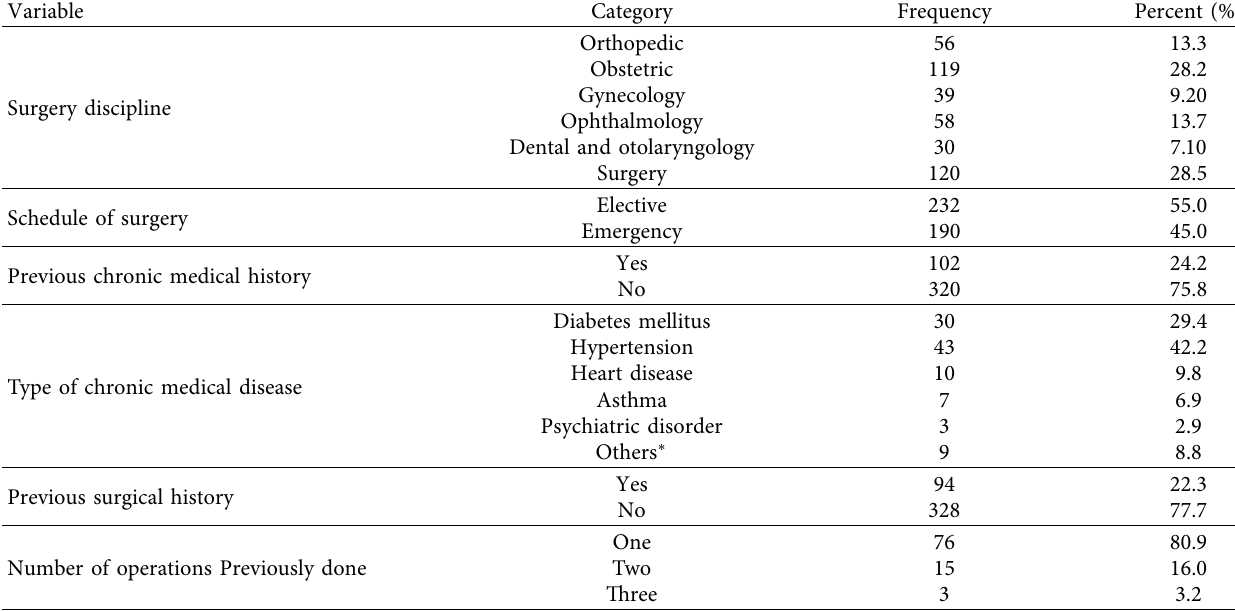
Table 2: Clinical-related characteristics of surgical patients in Dessie City Administration public hospitals, Northeast Ethiopia, 2021 ( N �